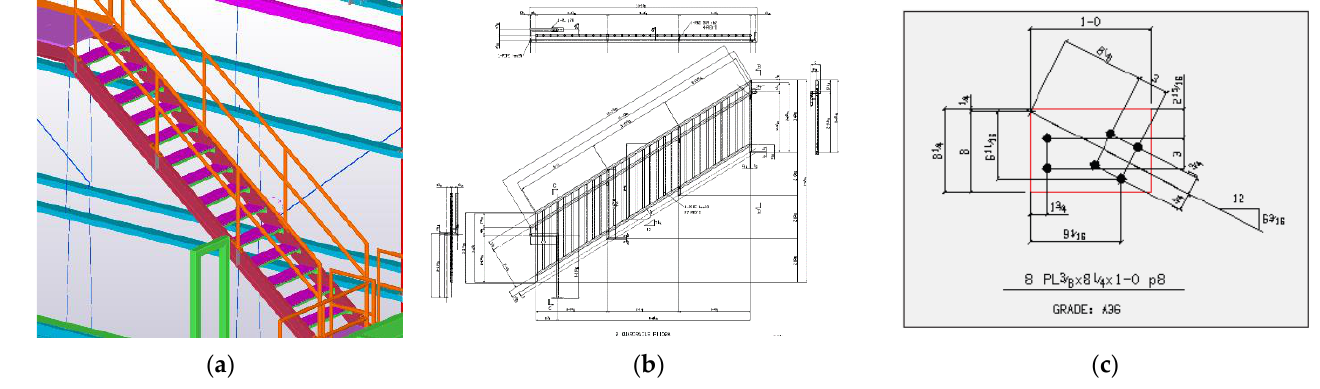
Figure 17. Steel BIM Fabrication — Study sample. ( a ) 1Tekla model LOD 400, ( b ) Automatic planimetry extraction, ( c ) CNC extraction.